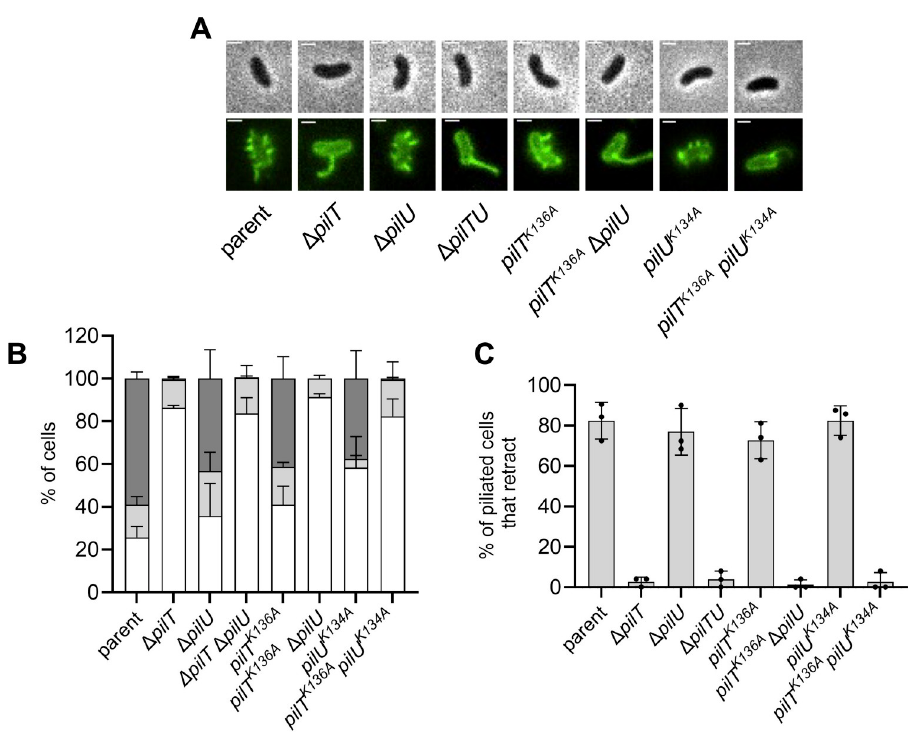
Fig 4. Retraction motor ATPase activity is required for MSHA surface piliation. ( A ) Representative images of piliated cells containing the indicated mutations to their retraction motor ATPases. Phase images (top) show cell boundaries and fluorescence images (bottom) show AF488-mal labeled pili. Scale bar = 1 μ m. ( B ) Quantification of piliation in strains from A . Cells were categorized as either having no pili (white bars), 1–2 pili (light gray bars), or at least 3 pili (dark gray bars). n = 300 cells analyzed from three independent biological replicates for all samples. Data for the parent and Δ pilT strains are identical to that presented in Fig 1C and are included again here for ease of comparison. ( C ) Quantification of retraction in strains from A . Graphs display the percentage of cells in each replicate that exhibited any pilus retraction during a three-minute timelapse. n � 25 piliated cells analyzed for each of the three biological replicates. All data are displayed as the mean ± SD. Parent and Δ pilT data from Fig 1C are included for comparison.